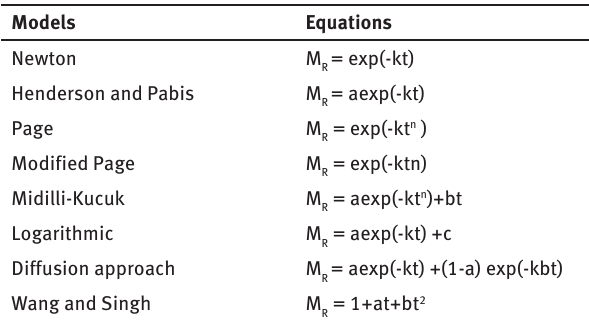
Table 2: Mathematical thin-layer drying models used for the